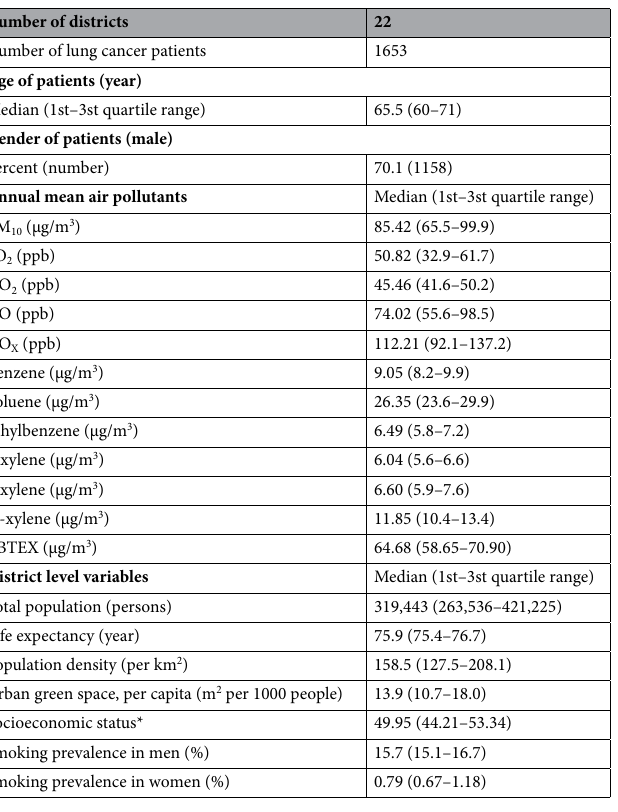
Table 1. Description of the study area, air pollution level, and district-level covariates. *Socio-economic status score according to the 16 variables mentioned in the method section. This variable does not have a unit. The lowest value of this score was 36.6 and the highest was